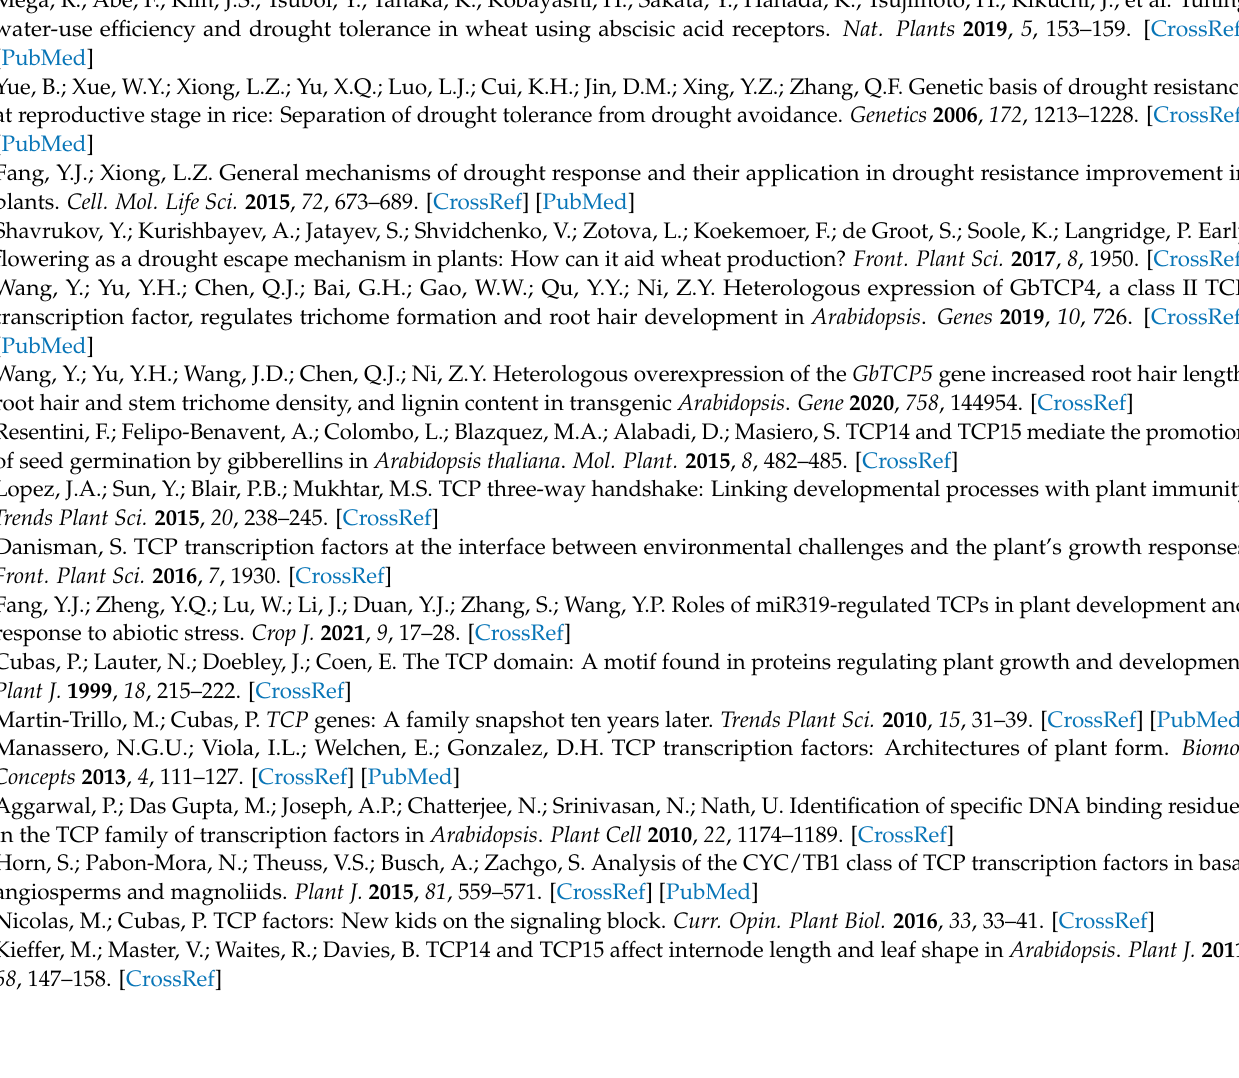
MaTCP genes. Table S3. The length of mulberry seedling roots at five developmental periods. Dataset S1. FASTA files of MaTCP proteins in